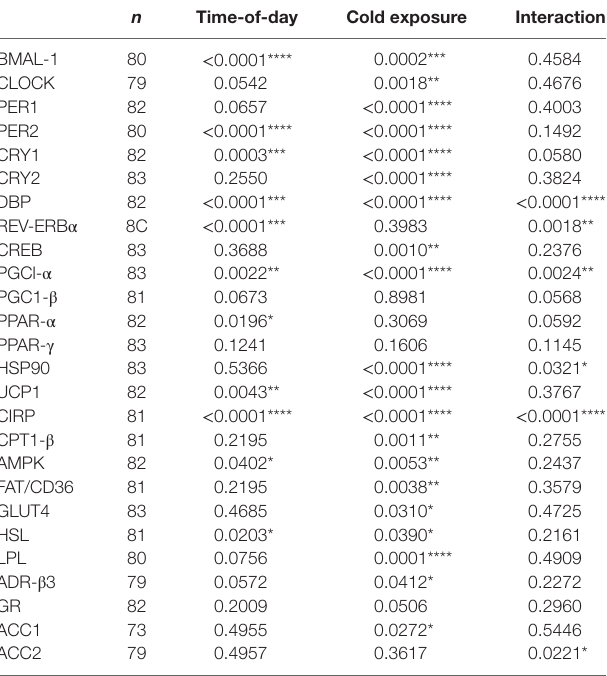
TaBle 4 | Significance levels observed for the two­way ANOVA analysis of gene expression in the brown adipose